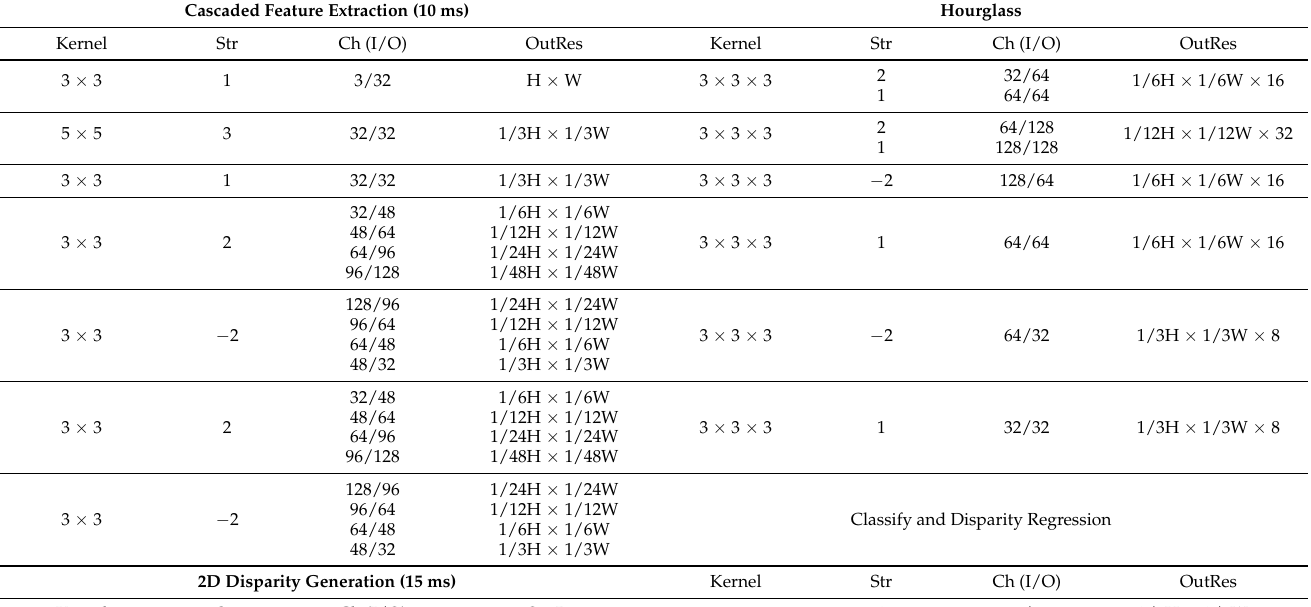
Table 1. Network parameter configuration. H and W are the height and width of the stereo images. The stride of − 2 means a deconvolution layer with a stride of 2. Str, Ch (I/O) and CDR are short for Stride, Channel (Input/Output) and classify and disparity regression respectively. Each layer is followed by batch normalization and Relu for non-linearities. Cascaded Feature Extraction (10